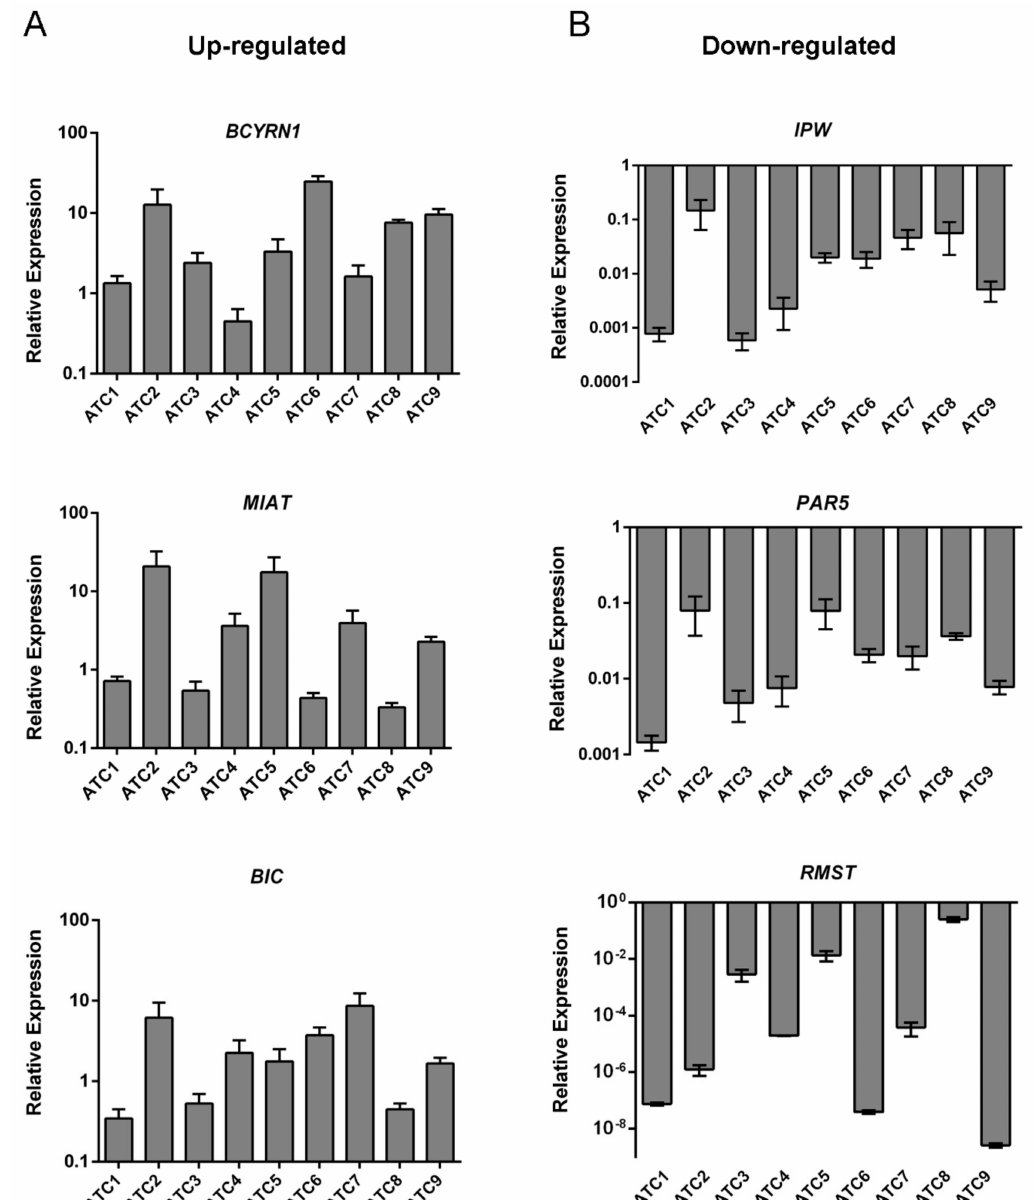
Figure 1. Expression analysis of lncRNAs deregulated in ATC samples. qRT-PCR analysis was carried out to evaluate the expression levels of three upregulated ( A ) and three downregulated ( B ) lncRNAs from the microarray analysis. Results are reported as 2 − ∆∆ Ct values ± standard deviation (SD) compared to the mean of five NT samples, set equal to